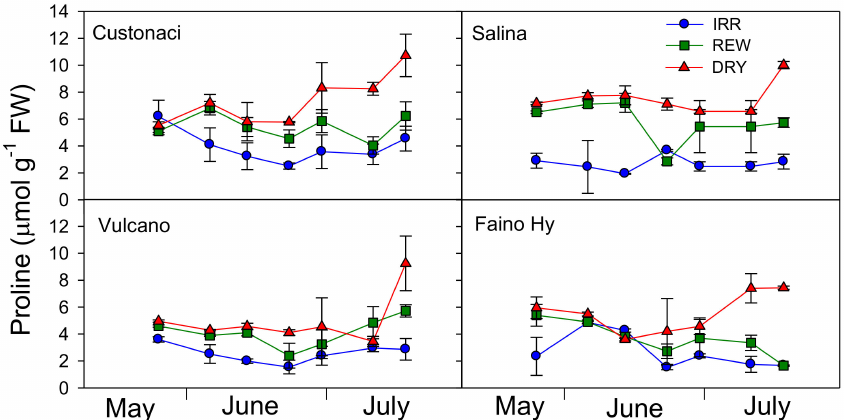
Figure 5. Leaf proline content ( µ mol g − 1 FW) in four genotypes of tomato in relation to the irrigation treatment (IRR: full irrigation; REW: rewatering; DRY: no irrigation). Vertical bars indicate the standard error ( n =